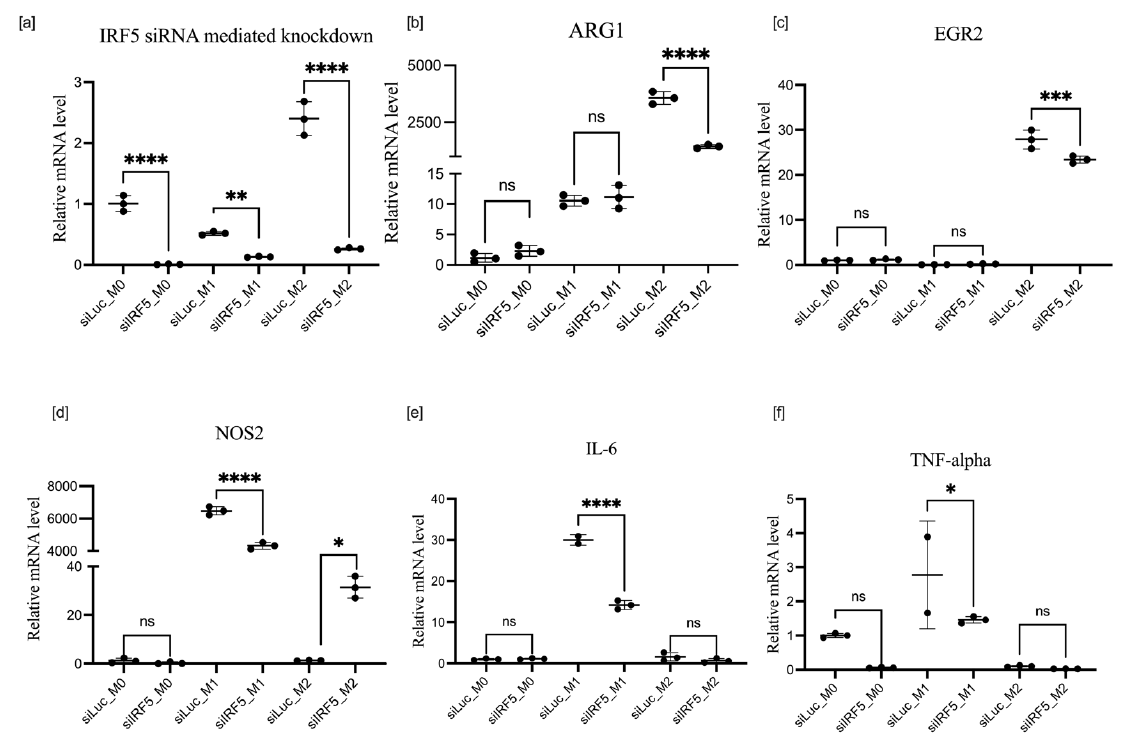
Figure 6. mRNA expression of IRF5 ( a ), ARG1 ( b ), EGR2 ( c ), NOS2 ( d ), IL-6 ( e ), and TNF- α ( f ) after IRF5 knockdown in macrophages treated according to protocol 2. Data are presented as mean ± SD, n = 3 [ns; not significant; * p < 0.05; ** p < 0.01; *** p < 0.001; **** p < 0.0001].